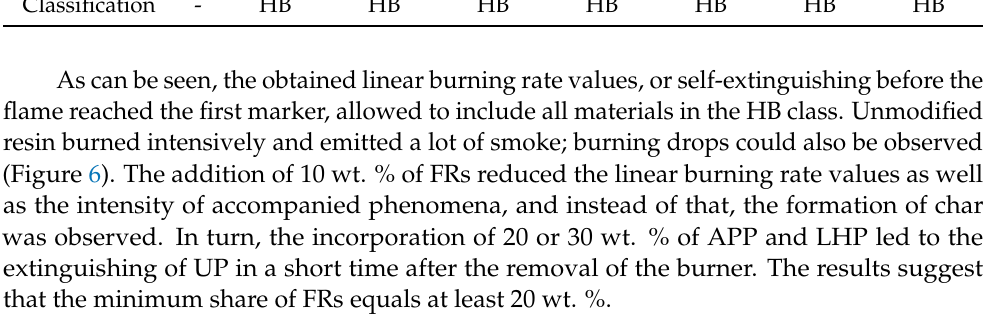
Table 3. Horizontal burning test of unmodified UP and resin with APP and LHP. Materials UP The linear burning rate, mm/min